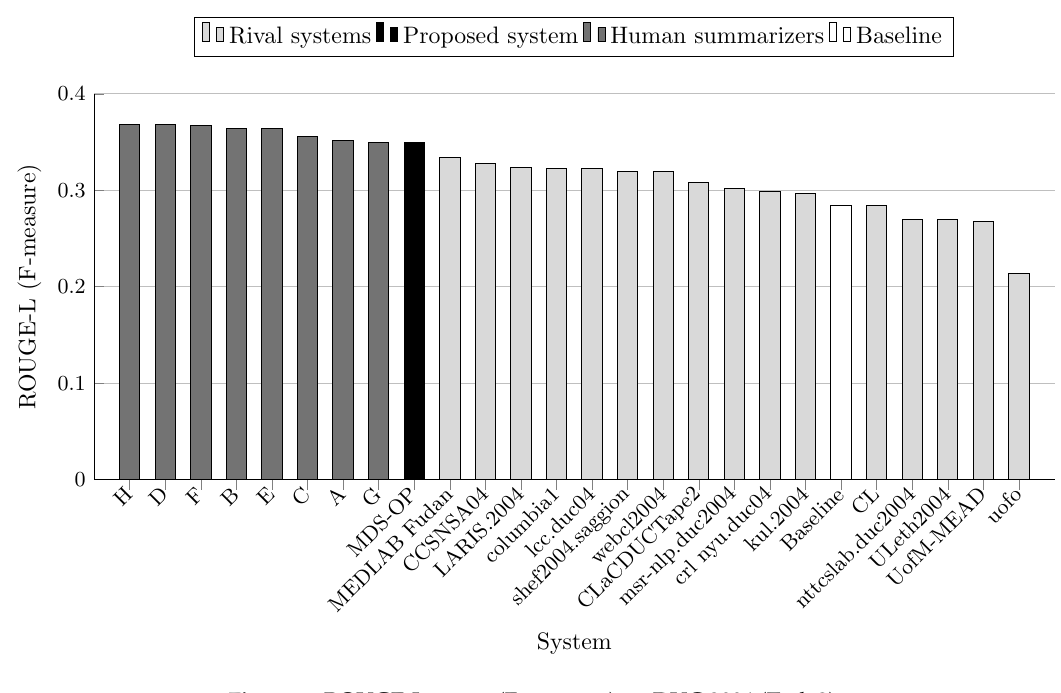
Figure 7. ROUGE-L scores (F-measure) on DUC 2004 (Task 2).